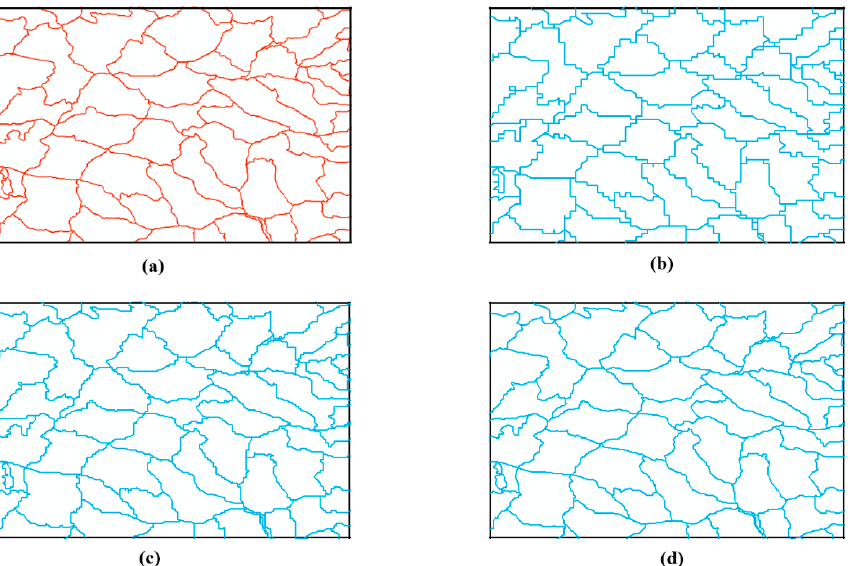
Figure 6. Visualization of compression results at different space division level. ( a ) is the result of the original data, ( b ) is the drawing result with a division level of 8, ( c ) is the drawing result with a division level of 9, and ( d ) is the drawing result with a division level of 10.